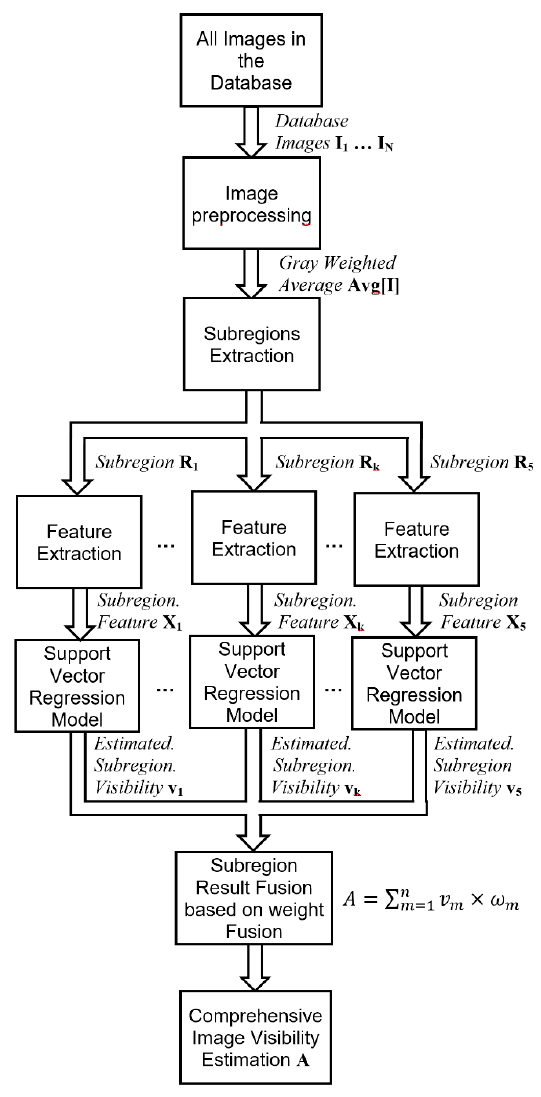
Figure 1. Flow Chart of Comprehensive Visibility Evaluation.